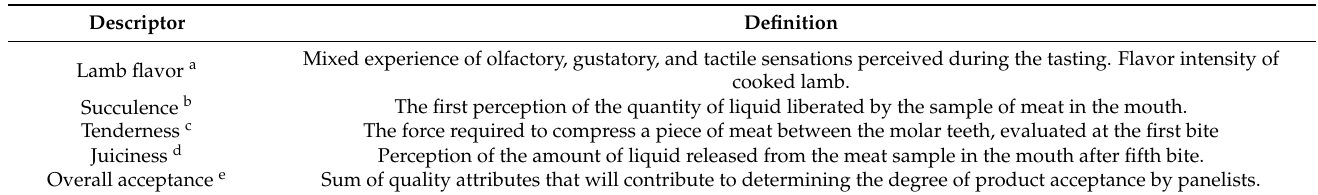
Table 3. Descriptors used in the quantitative descriptive sensory analysis of lamb